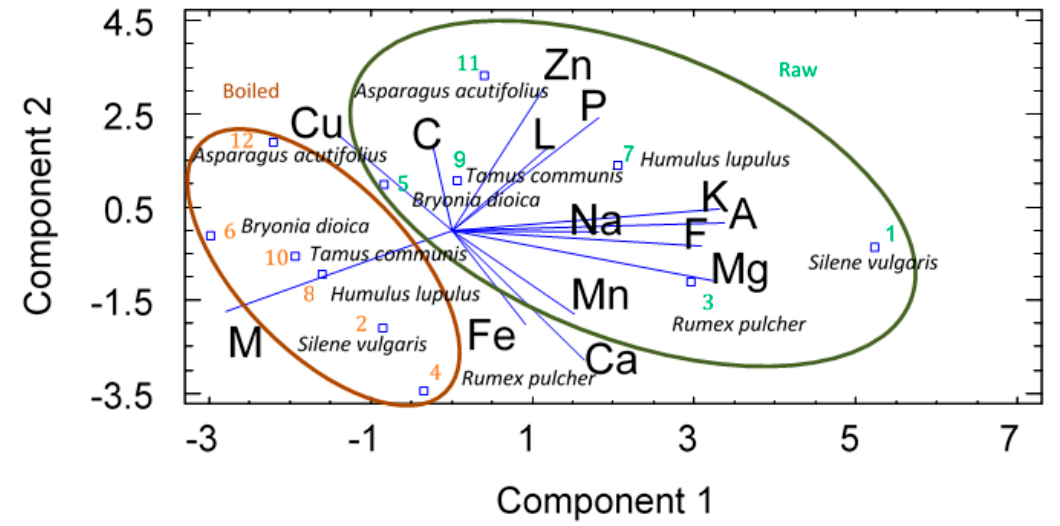
Figure 3. Principal component analysis (PCA) graphs of nutrients from the raw (1, 3, 5, 7, 9 and 11) and boiled vegetables (2, 4, 6, 8, 10 and 12) investigated. Numbers on the plot represent analyzed vegetables. Sample numbering for raw and boiled respectively: 1, 2: Silene vulgaris ; 3, 4: Rumex pulcher ; 5, 6: Bryonia dioica ; 7, 8: Humulus lupulus ; 9, 10: Tamus communis ; 11, 12: Asparagus acutifolius . L: lipids; P: